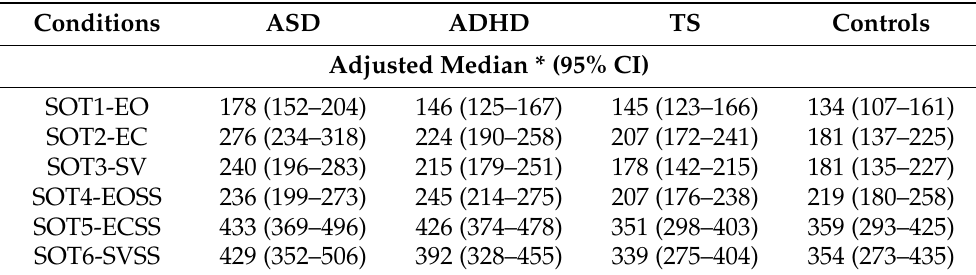
Table 3. Performance in the perimeter parameter among NDD conditions and